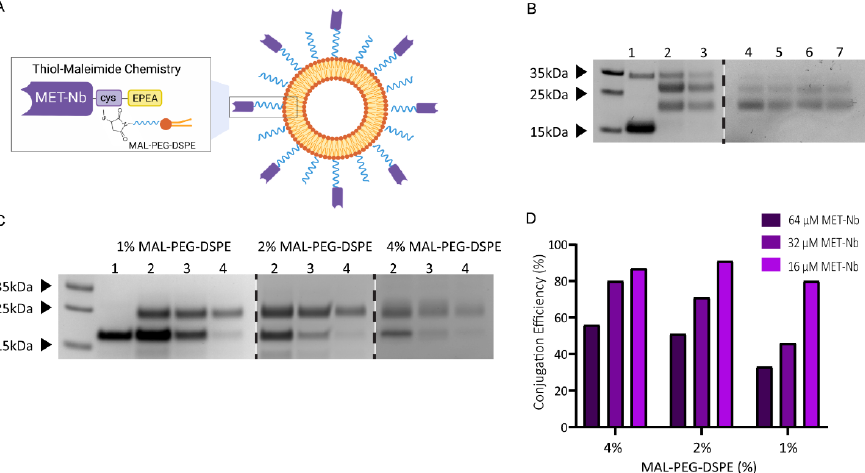
Figure 1. MET-Nb conjugation efficiency depends on TCEP reduction conditions and the percentage of MAL-PEG-DSPE and yields a different number of MET-Nbs per liposome. ( A ) Schematic of MET-targeted liposomes (MET-TLs) prepared via thiol-maleimide click chemistry. ( B ) Effect of the TCEP reduction conditions on MET-Nb conjugation efficiency to liposomes with 8% MAL-PEG-DSPE. SDS-PAGE with Coomassie blue staining: (1) free nanobody; (2) and (3) MET-TLs with 32 and 16 µM of MET-Nbs, respectively, and with MET-Nbs pre-treated with TCEP for 15 min at RT; (4) and (5) MET-TLs with 32 and 16 µM of MET-Nbs, respectively, and with MET-Nbs pre-treated with TCEP for 5 min at RT; (6) and (7) MET-TLs with 32 and 16 µM of MET-Nbs, respectively, and with MET-Nbs pre-treated with TCEP for 15 min on ice. ( C ) Effect of the percentage of MAL-PEG-DSPE on MET-Nb conjugation efficiency assessed by SDS-PAGE: (1) free nanobody; (2), (3), and (4) MET-TLs with 64, 32, and 16 µM of MET-Nbs, respectively, with 1, 2, and 4% of MAL-PEG-DSPE, respectively. ( D ) MET-Nb conjugation efficiency (%) at 1, 2, and 4% of MAL-PEG-DSPE estimated by comparing the band intensity of free and conjugated MET-Nbs using the Plot Lanes tool from ImageJ.